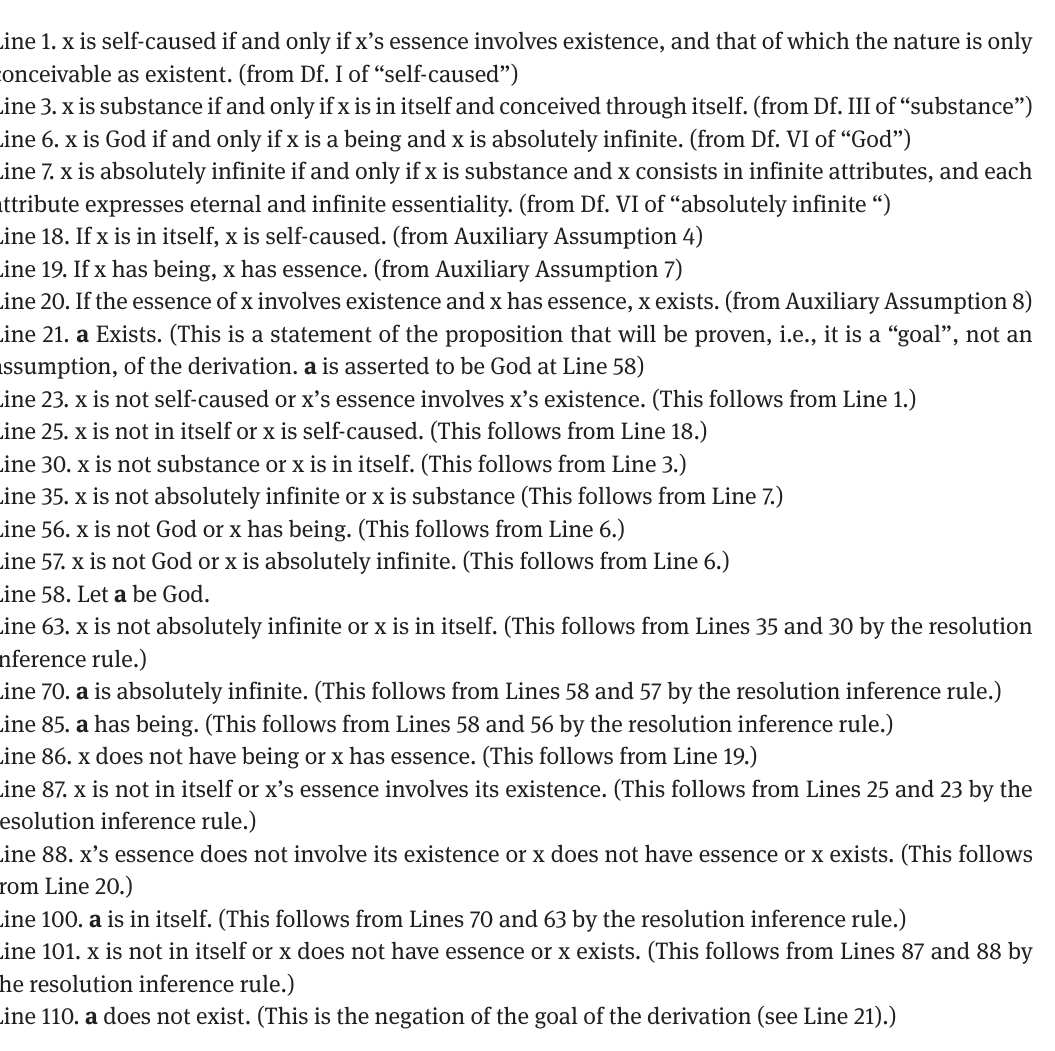
Figure 10: An extract from the proof of (GE) that is generated by prover9 , using the file shown in Figure 9 as input. The full output of prover9 for this case is contained in Appendix 8. “. . .” signifies text in the original that I deleted. Here’s how to read Figure 10. prover9 first translates some of the input file (in this case, the DAPI, together with a proposition to be derived) to a set of sentences in a specific clausal form that is logically equivalent to sentences input to prover9